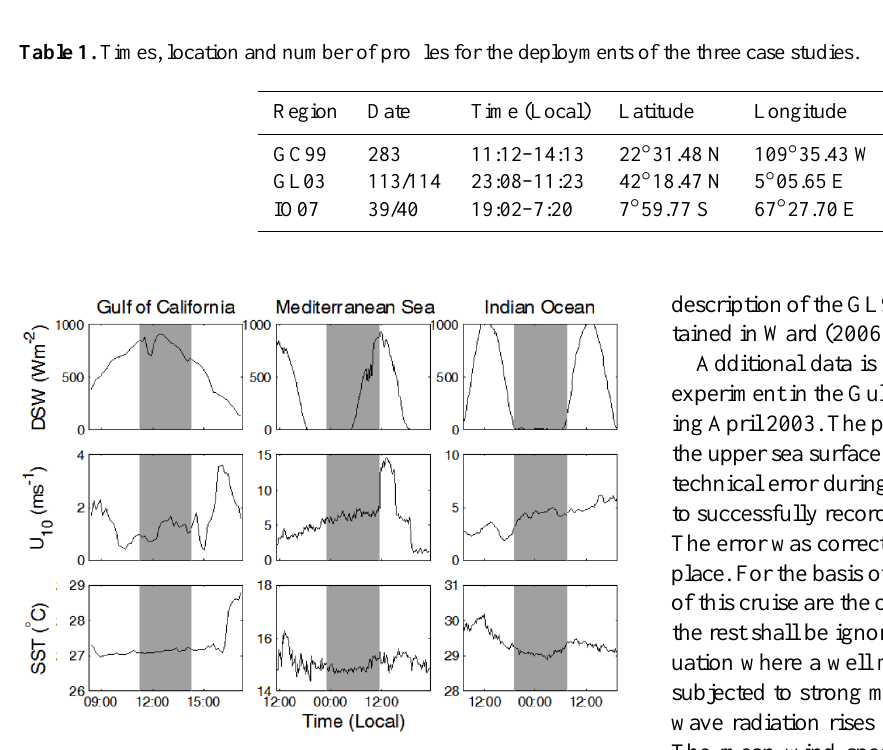
Fig. 1. Time series of the downwelling shortwave radiation, wind Fig. 1 : Time series of the downwelling shortwave radiation, wind speed, and skin temperature speed, and skin temperature for the GC99, GL03 and IO07 peri- for the GC99, GL03 and IO07 periods respectively. The grey vertical column marks the time of ods respectively. The grey vertical column marks the time of the the deployment period. The data is 60 minute averaged. deployment period. The data is 60min